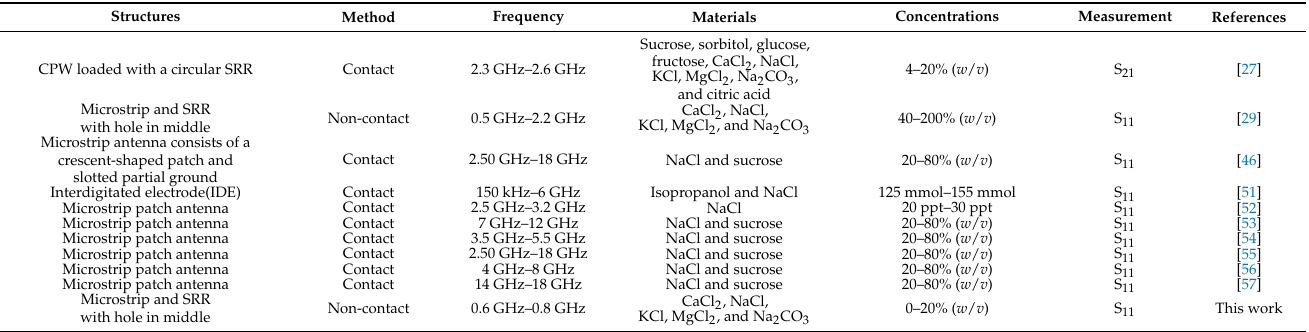
Table 5. Comparison table for various microwave sensor detection of salt